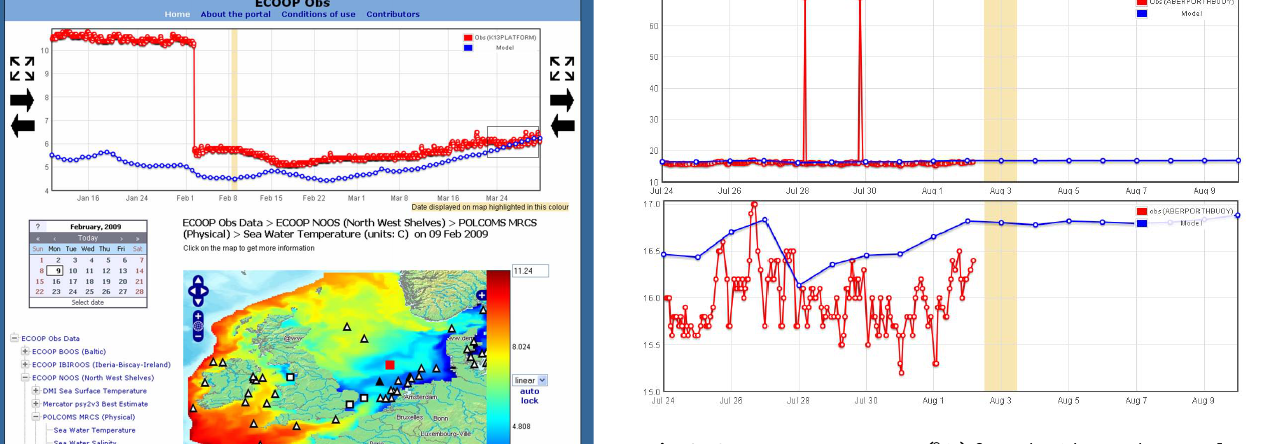
Fig. 6. Sea water temperature ( ◦ C) from the AberporthBuoy plat- form. One of the benefits of using a dynamic plotting library in the web portal is that if rogue data points are disturbing the y-axis scal- ing, they may be highlighted (top panel) and removed, resulting in auto-scaling of the y-axis to the correct range for the genuine data values (bottom